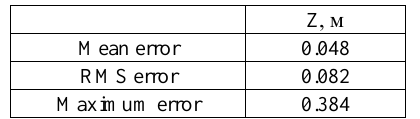
Table 7. Vertical positional accuracy estimation of dense DSM